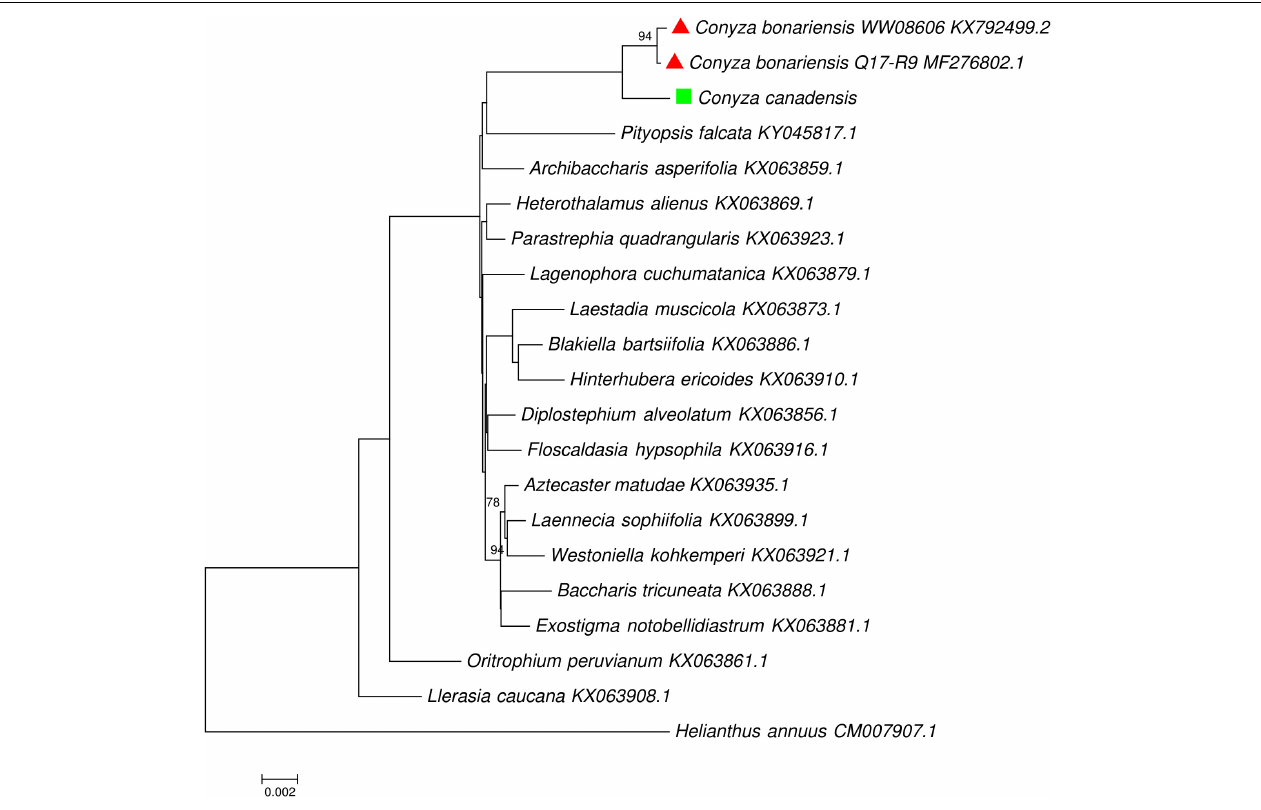
FIGURE 4 | Maximum likelihood phylogenetic tree inferred from complete chloroplast genomes from tribe Astereae, one representative per genus (three cp genomes for Conyza ), with Helianthus annuus as the outgroup. Taxon names of C. bonariensis and C. canadensis were labeled with red triangle and green square, respectively.